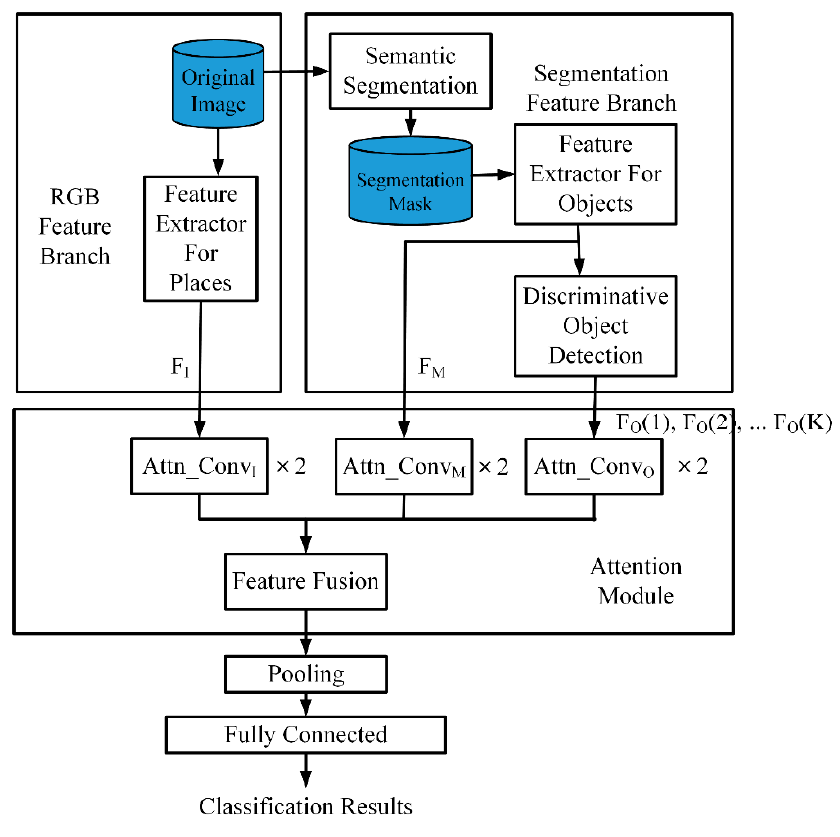
Figure 1. Scene classification